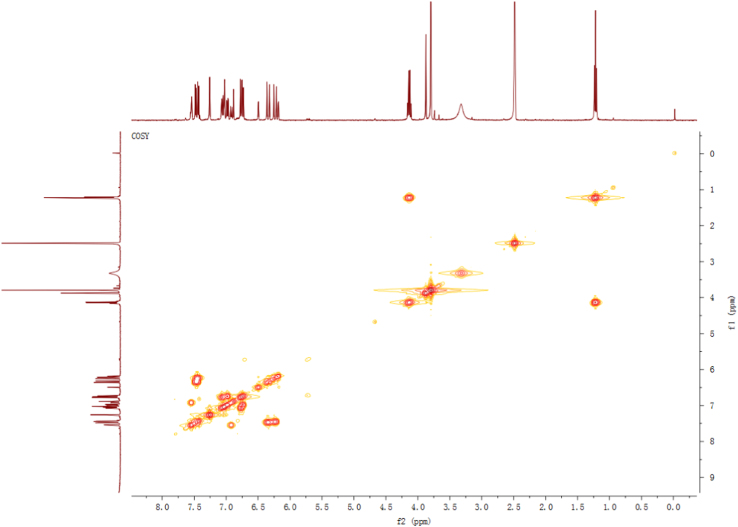
1H–1H COSY spectrum of compound 3.